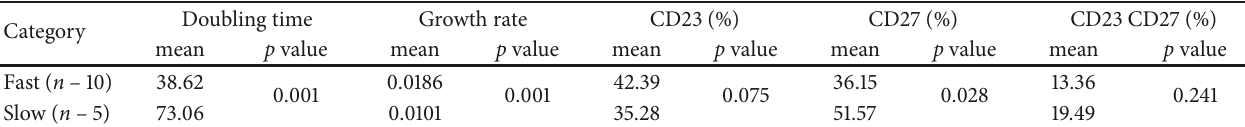
Table 4: Statistical analysis of CD23, CD27, and CD23CD27 expression of fast- and slow-growing LCLs.